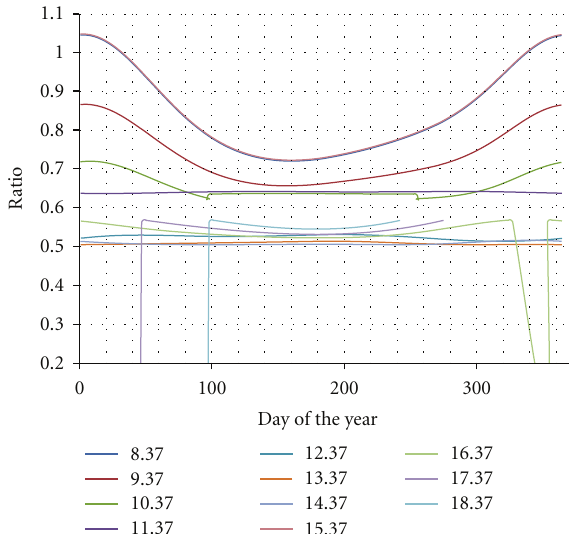
Figure 21: Ratio of mirror 5 along the year (shadows are consid- ered).